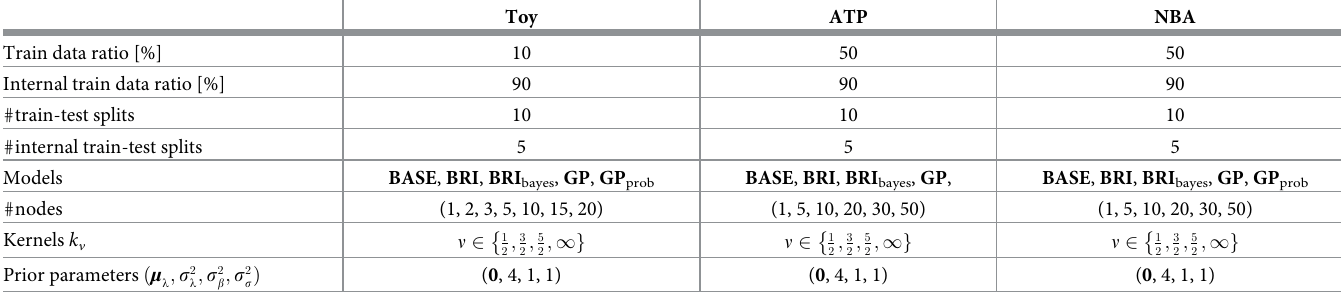
Table 1. Experiments’ parameters